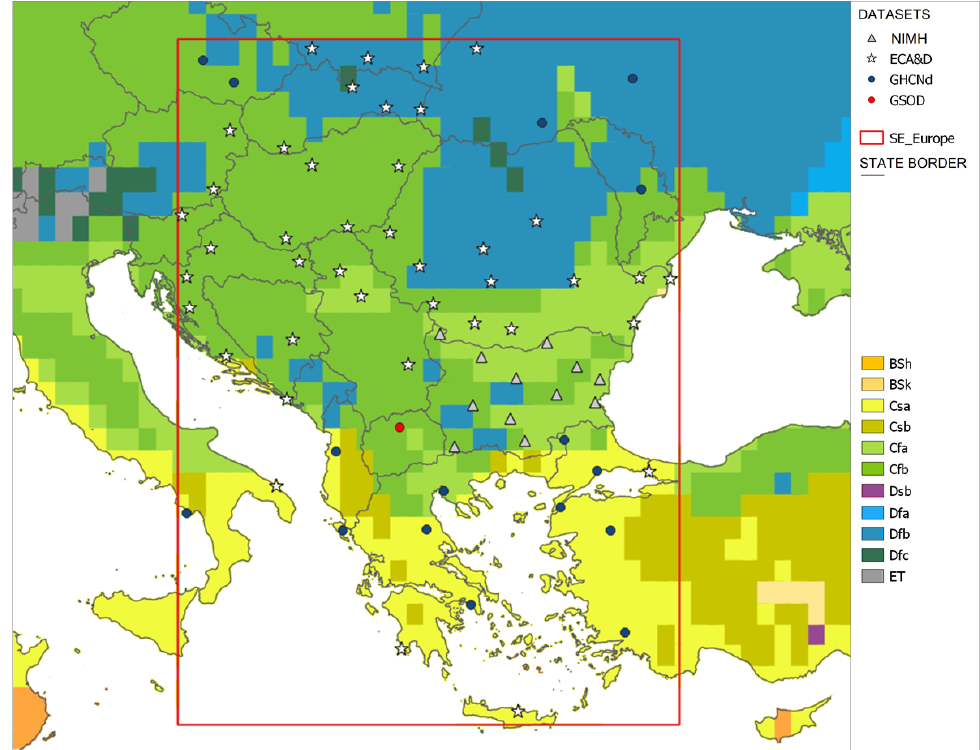
Figure 1. Location of meteorological stations used in the study on the background of the map of Köppen–Geiger classification (1951–2000) [32], data source: http://koeppen-geiger.vu-wien.ac.at/ present.htm (accessed on 16 July 2022); the selected stations are marked as follow: grey triangles— 12 stations from the NIMH network; blue and red dots—16 stations from GHCNd and one from GSOD datasets, respectively; asterisks—41 stations from ECA&D